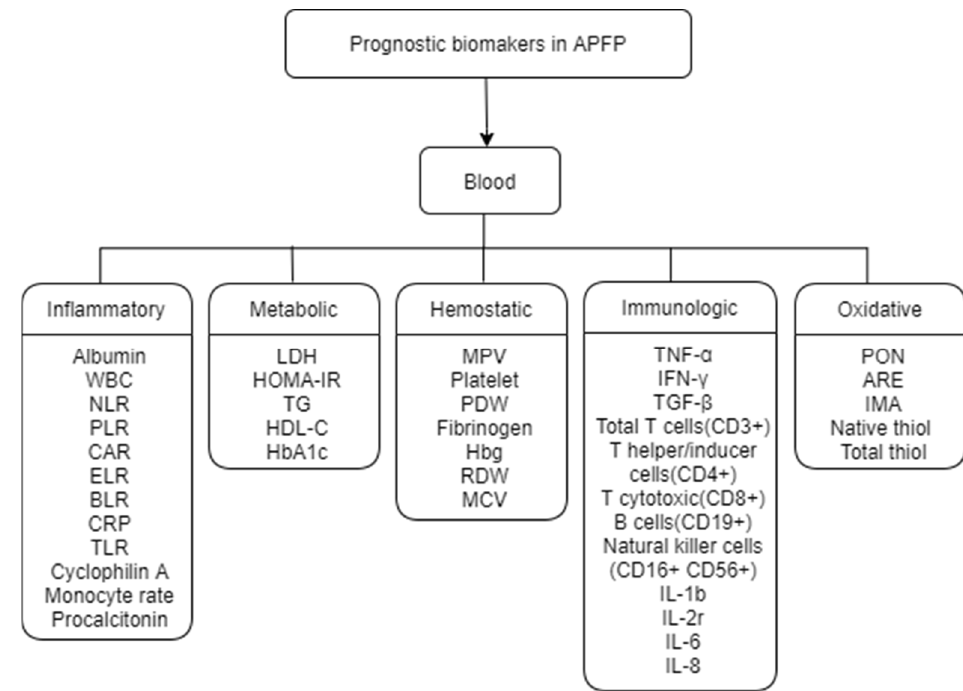
Figure 2. Diagram illustrating the review biomarkers.